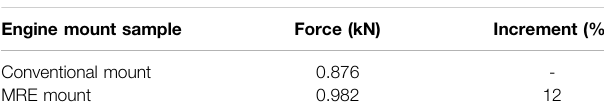
TABLE 6 | Maximum force (kN) of the engine mounts.